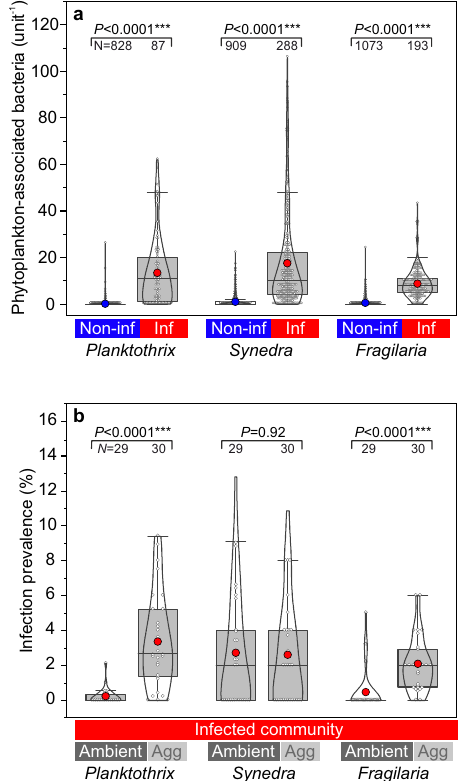
Fig. 6 Bacterial abundances and infection prevalence in fi eld-sampled phytoplankton. a Bacterial abundances on non-infected and fungal-infected phytoplankton cells. The numbers of associated bacteria are given per 100 µ m fi lament length ( Planktothrix ) or per diatom cell ( Synedra and Fragilaria ). b Infection prevalence in the ambient water and aggregates, after cell aggregation in rotating cylinders. N indicates the number of analyzed cells a or the number of aggregates and ambient water samples b . Data are shown as single data points (white circles), the 25th, 50th, and 75th percentile (grey boxes), mean values (blue and red circles), and distribution curves (kernel